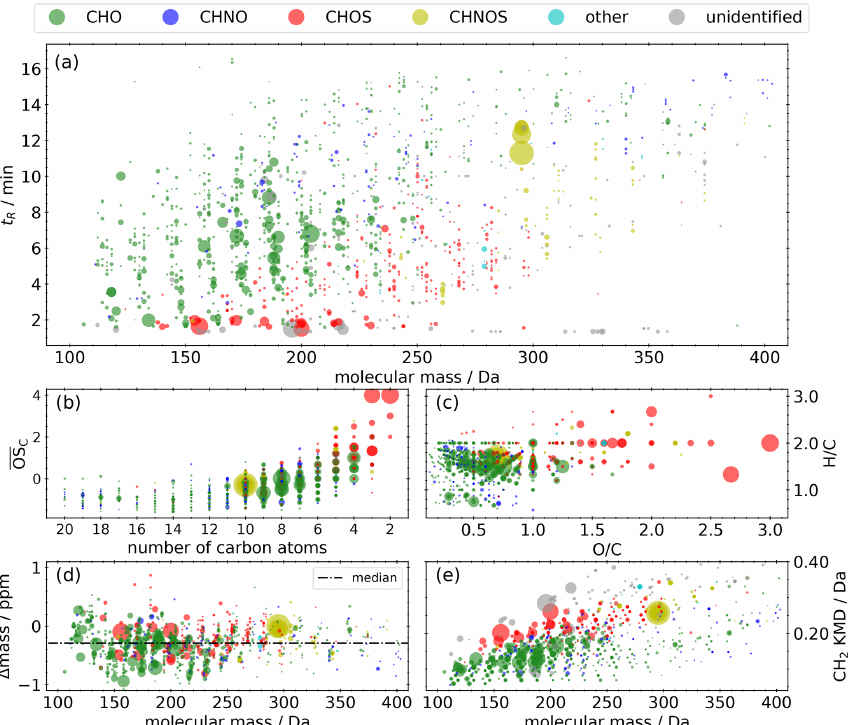
Figure 4. Molecular fingerprint of the representative selection of the field campaign samples. The area of the scatters represents the qualitative mean signal intensity on a linear scale. (a) Retention time vs. molecular mass. (b) Kroll diagram. (c) Van Krevelen diagram. (d) Mass difference between calculated and measured molecular mass ( (cid:49) mass) vs. molecular mass. (e) Kendrick mass defect plot. Panels (b) , (c) , and (d) only include compounds with a predicted